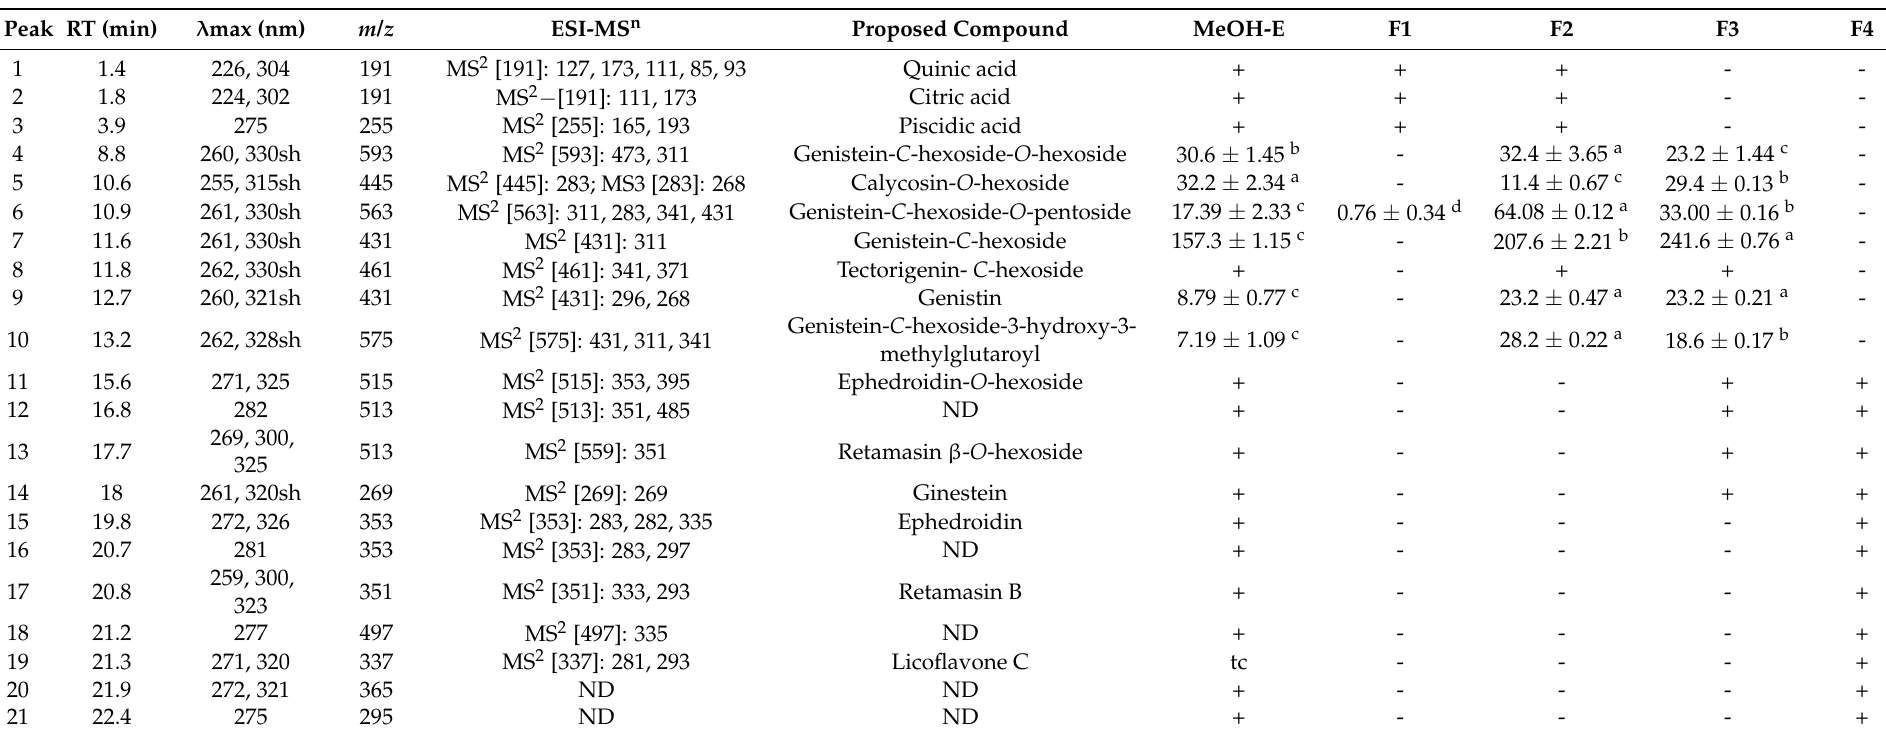
Table 2. UHPLC-DAD-ESI-MS n analysis of R. raetam MeOH-E extract and subsequent fractions F1, F2, F3 and F4 obtained after column chromatography purification.